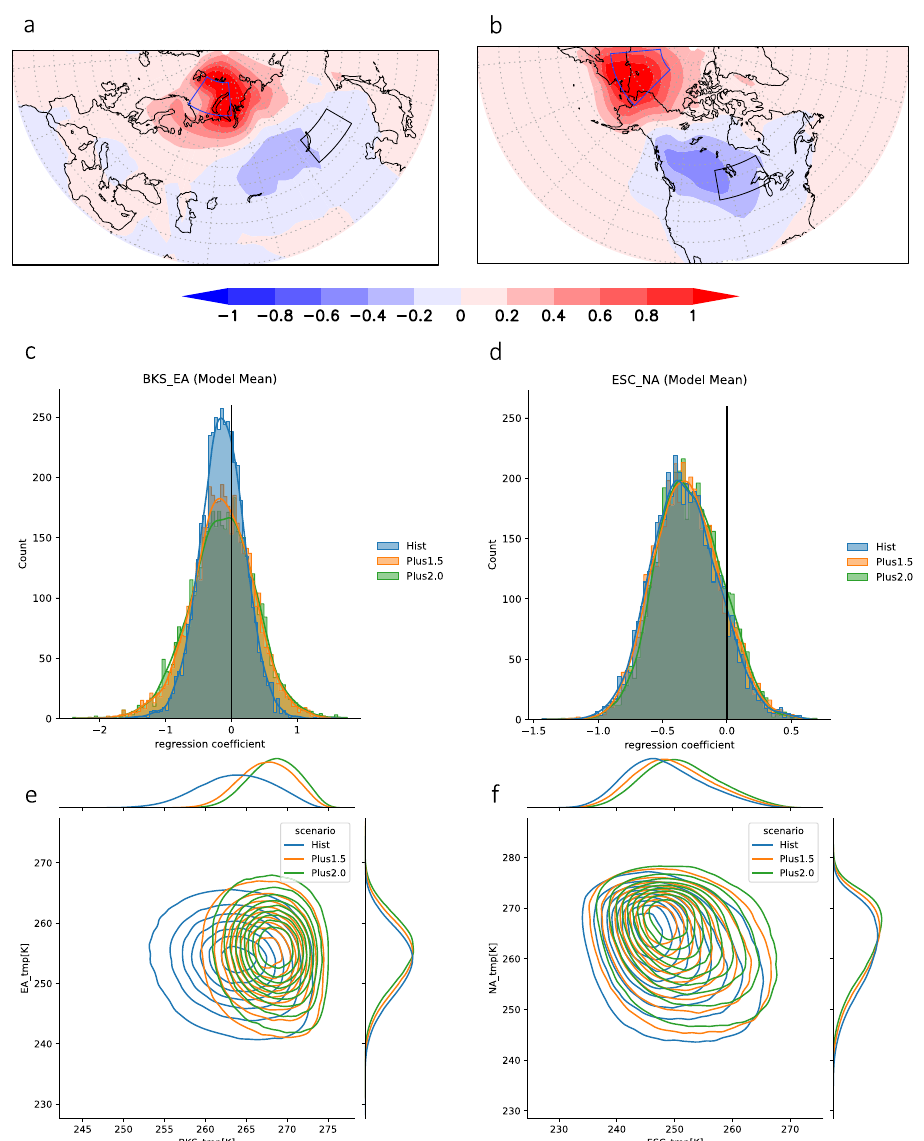
Fig. 2 Relationship between the Arctic and midlatitude under global warming. a , b The averaged regression coef fi cients of near-surface temperature with respect to the Barents-Kara sea (30° – 70°E, 70° – 80°N) and East Siberia Chukchi sea (160° – 200°E, 65° – 80°N) near-surface temperature from 5 models with 100-ensembles in HAPPI experiment Hist scenario. c , d The histogram of the regression coef fi cients in East Asia (105° – 125°E, 47° – 55°N) and North America (255°-275°E, 45° – 53°N) with respect to the Barents-Kara sea and East Siberia Chukchi sea under HAPPI experiments Hist, Plus1.5 and Plus2.0 scenarios. e , f Joint plot of the temperature in East Asia and Barents-Kara, and North America and East Siberia Chukchi sea. Line in the box shows the kernel density estimation of the temperature. Top and right graph shows the distribution of the temperature. Hist, Plus1.5 and Plus2.0 scenario are represented in blue, orange and green